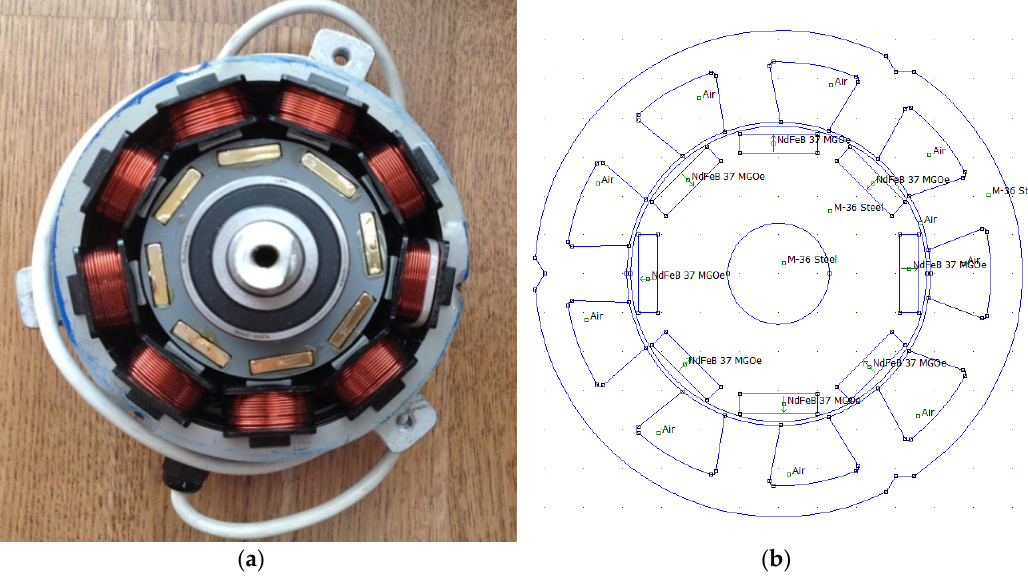
Figure 10. Real model ( a ) and simulation model ( b ) of the motor being tested.